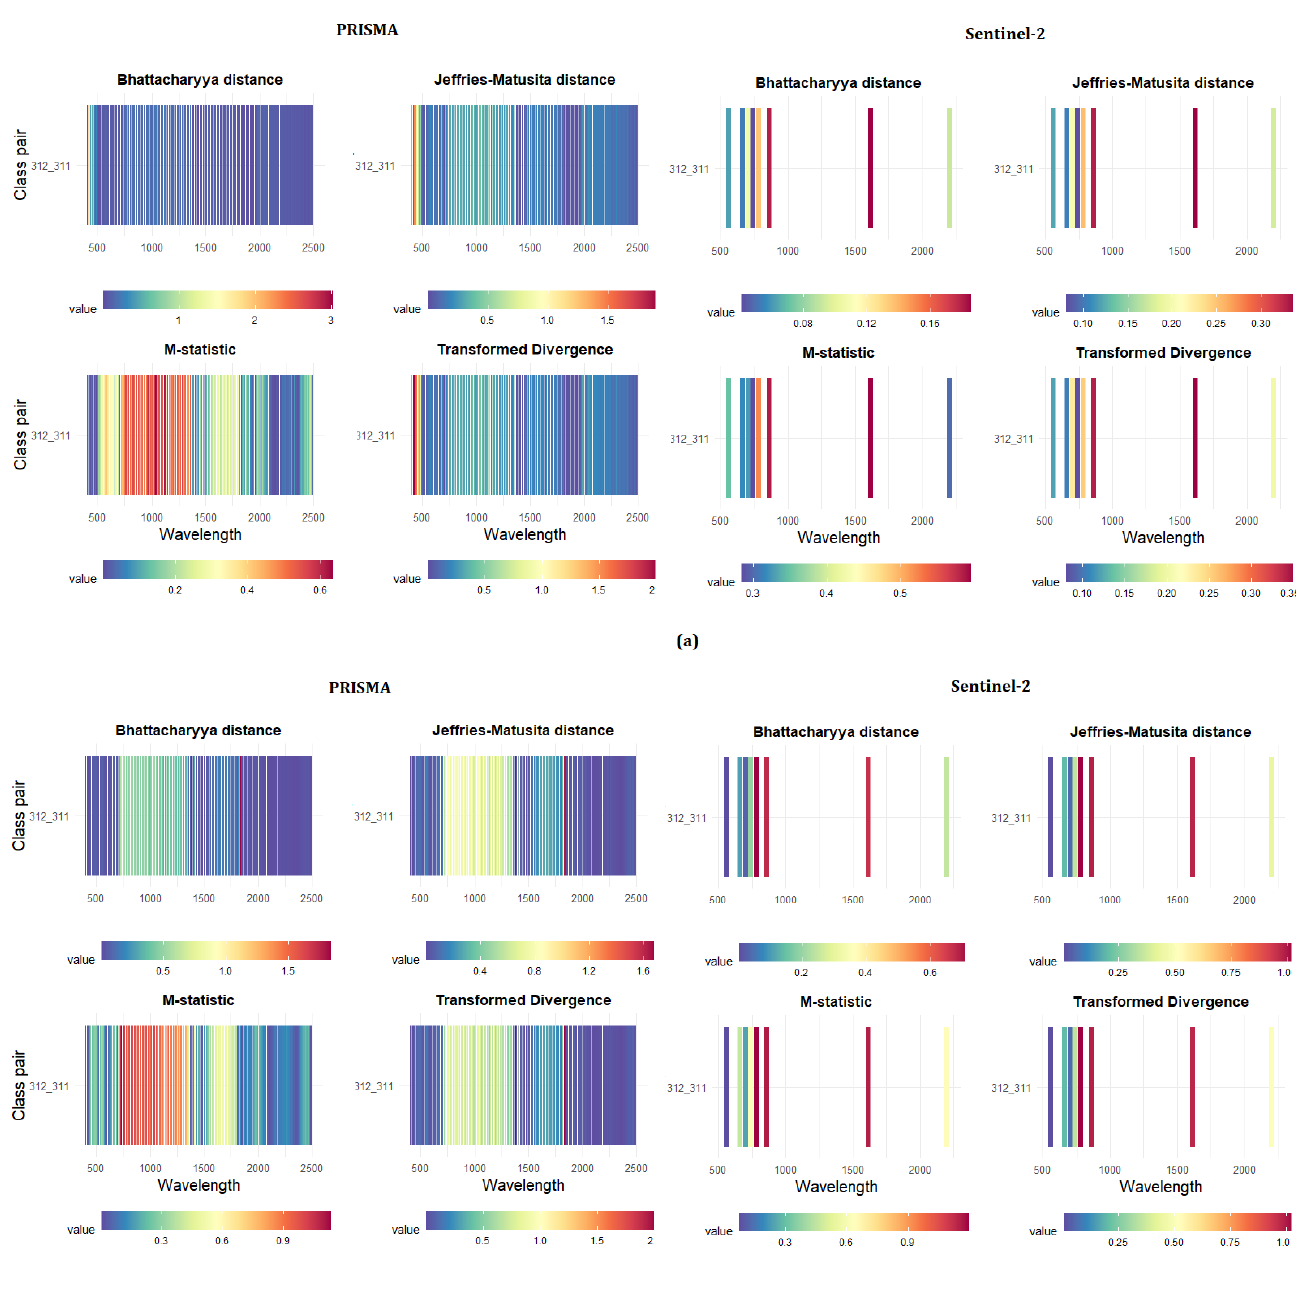
Figure 5. Results of the separability analysis for the third level nomenclature system, divided by statistical metrics and class pairs. The horizontal and vertical axes represent the wavelength and the pairwise vegetation combinations, respectively. The color of each grid cell represents the separability of the corresponding band and class pair, as reported by the legend bar at the bottom of the sub-panels. The higher the value is, the more separable the two classes become: ( a ) Area 1; and ( b ) Area 2.